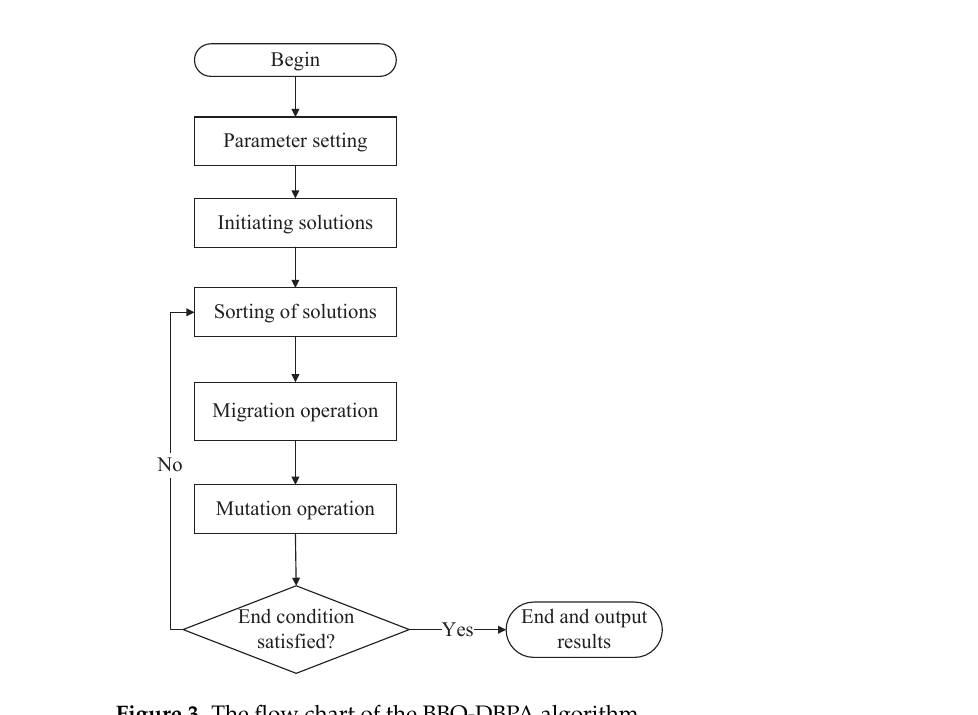
Figure 3. The flow chart of the BBO-DBPA